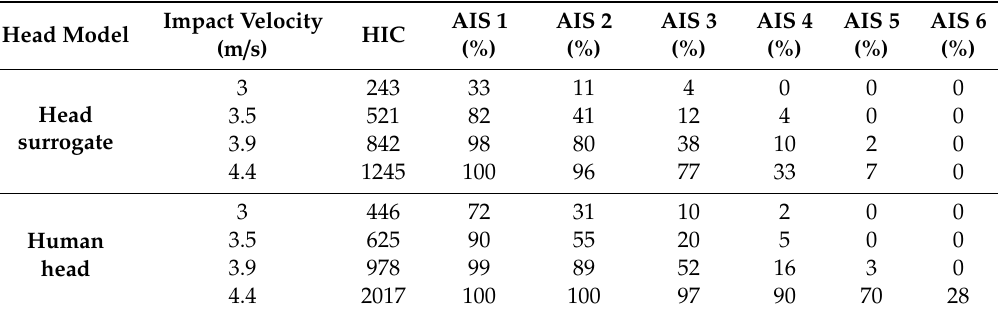
Table 11. HIC and AIS (%) for di ff erent impact